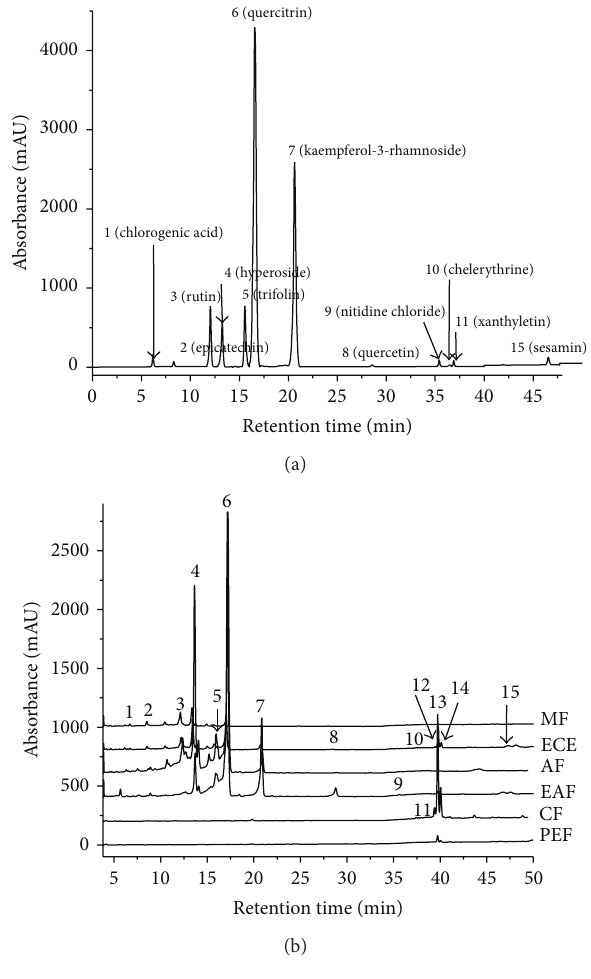
Figure 1: HPLC analysis of extracts and fractions from Z. bungeanum leaves. (a) Chromatography of the twelve standard compounds. (b) Chromatography of the ethanol extracts and their five fractions (ECE, PEF, CF, EAF, AF, and MF) monitored at 254 nm and identified by their retention time (min): chlorogenic acid (6.62, peak 1), epicatechin (8.31, peak 2), rutin (12.12, peak 3), hyperoside (13.61, peak 4), trifolin (15.73, peak 5), quercitrin (16.82, peak 6), Kaempferol-3-rhamnoside (20.61, peak 7), quercetin (28.32, peak 8), nitidine chloride (35.61, peak 9), chelerythrine (36.95, peak 10), xanthyletin (37.20, peak 11), and sesamin (46.44, peak 15). Peaks 9–11 were very weak.